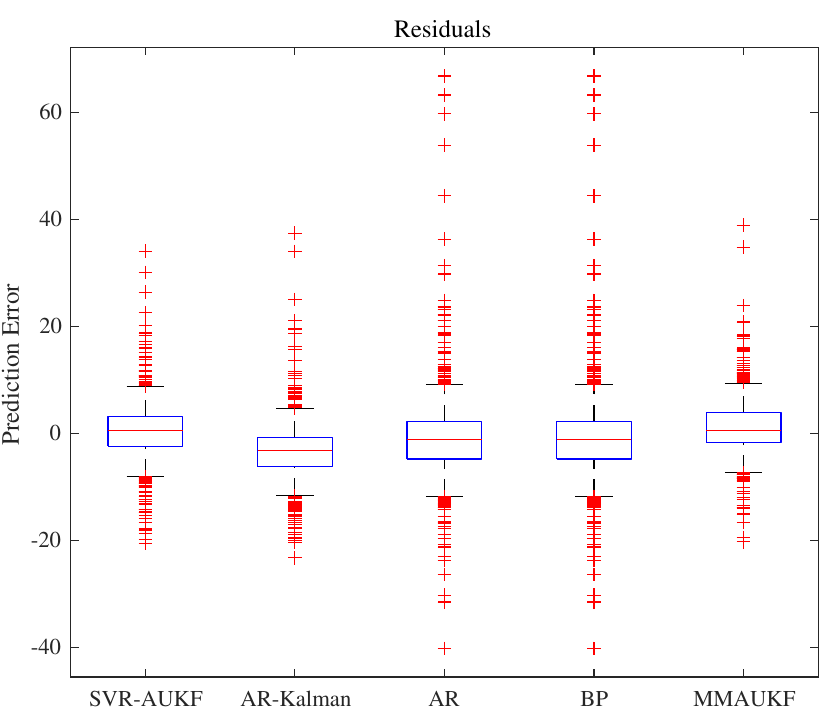
Figure 17. The comparison results of the proposed MMAUKF method and SVR-AUKF, AR-Kalman, AR and BP